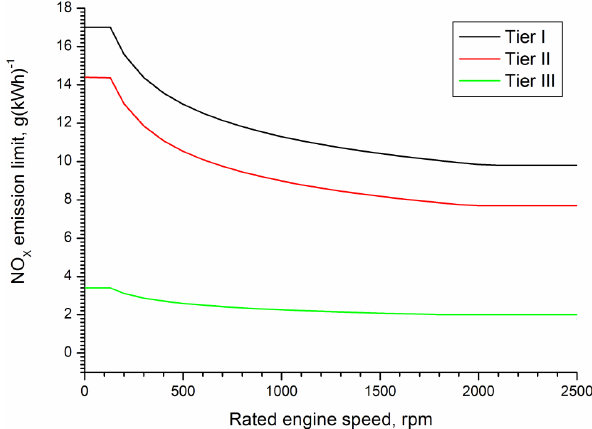
Fig. 2. NO x emission limits, at different rated engine speeds, for Figure 2. NO X emission limits, at different rated engine speeds, for ships built after 973 ships built after 2000 (Tier I), after 2011 (Tier II), and after 2016 in 2000 (Tier I), after 2011 (Tier II), and after 2016 in emissions control areas (Tier III). 974 emissions control areas (Tier